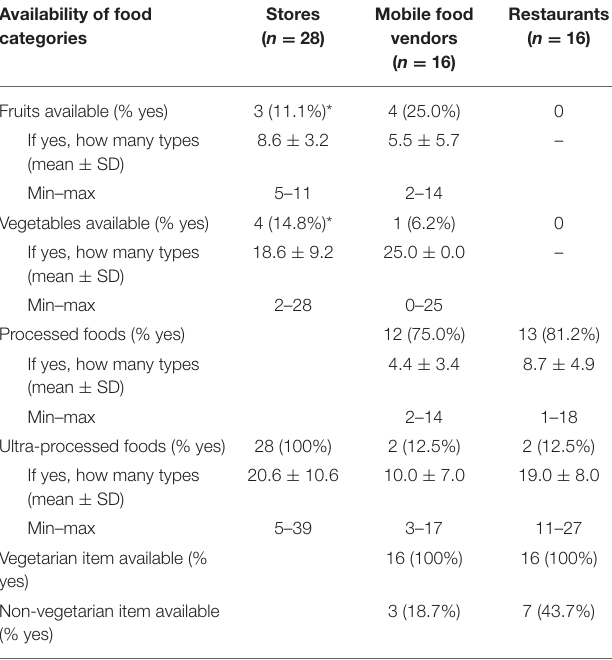
TABLE 4 | Availability and variety of food items according to level of processing across surveyed food establishments ( n = 60) of Delhi National Capital Region,